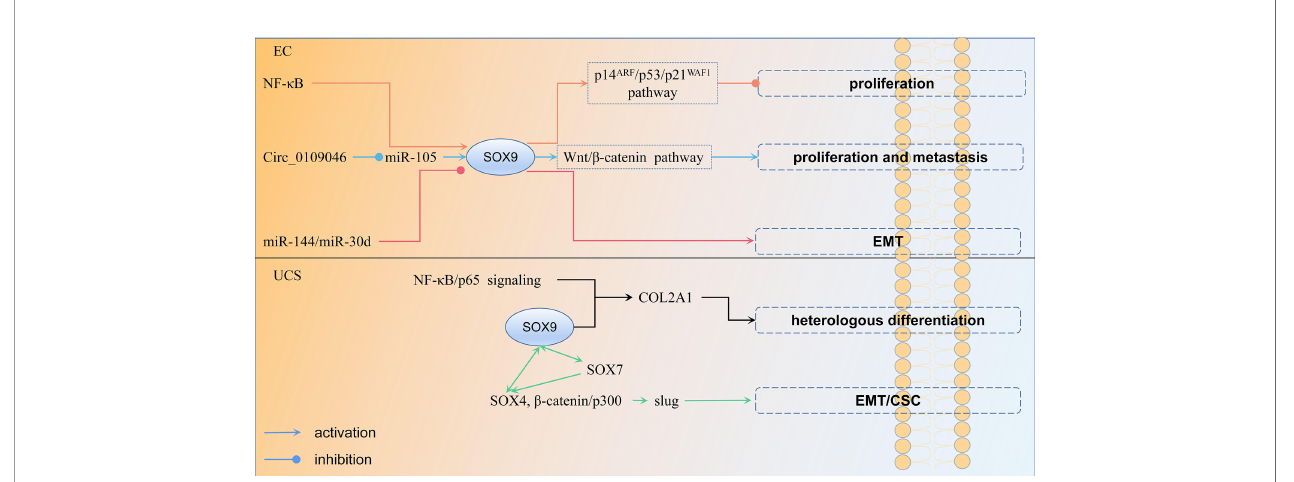
FIGURE 4 | The regulation mechanism of SOX9 in endometrial cancer and uterine carcinosarcoma each color represent a regulation mechanism of SOX9